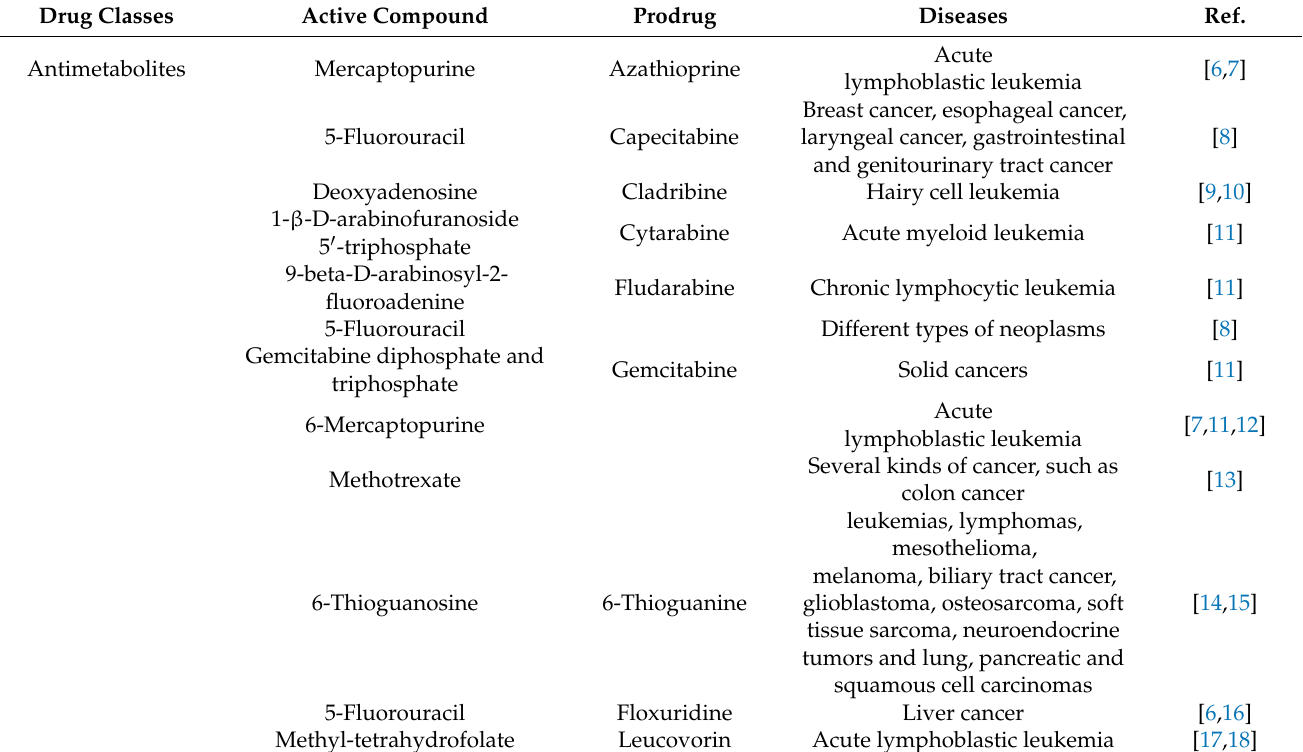
Table 1. List of the anticancer drugs and prodrugs and the diseases in which they are most used. Drug Classes Active Compound Prodrug Diseases